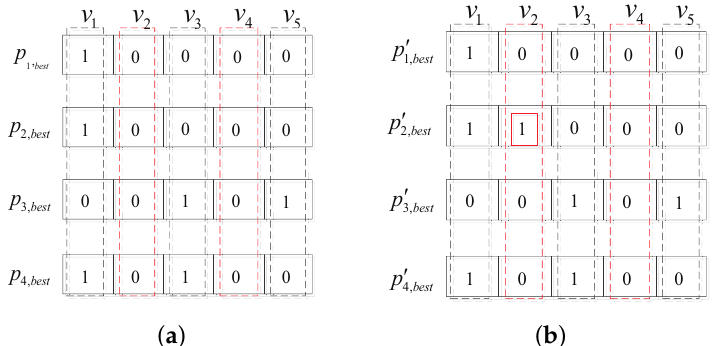
Figure 8. The processing method of isolated vertices: ( a ) Hypergraph obtained at the current iteration; ( b ) hypergraph after processing isolated